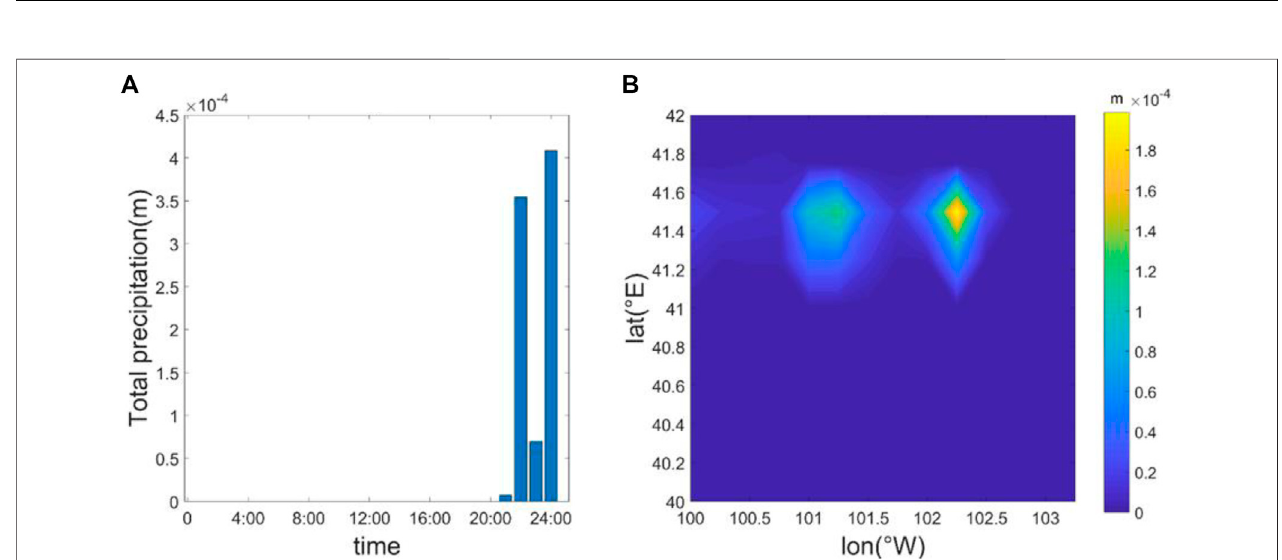
FIGURE4| TheprecipitationdataonJanuary15,where (A) showsthehourlyprecipitationinthetargetarea,and (B) showsthedistributionofprecipitationfrom20: 00 to 24:00.